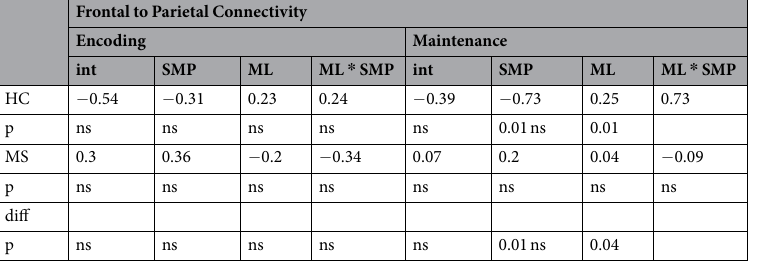
Table 2. Single trial regression with both groups Granger Causality between frontal (FZ) and parietal (CP3) electrodes. Positive values indicate frontal to parietal connectivity. SMP: Successful memory performance, ML: Memory load, HC: healthy controls, MS: patients with Multiple Sclerosis, ns: